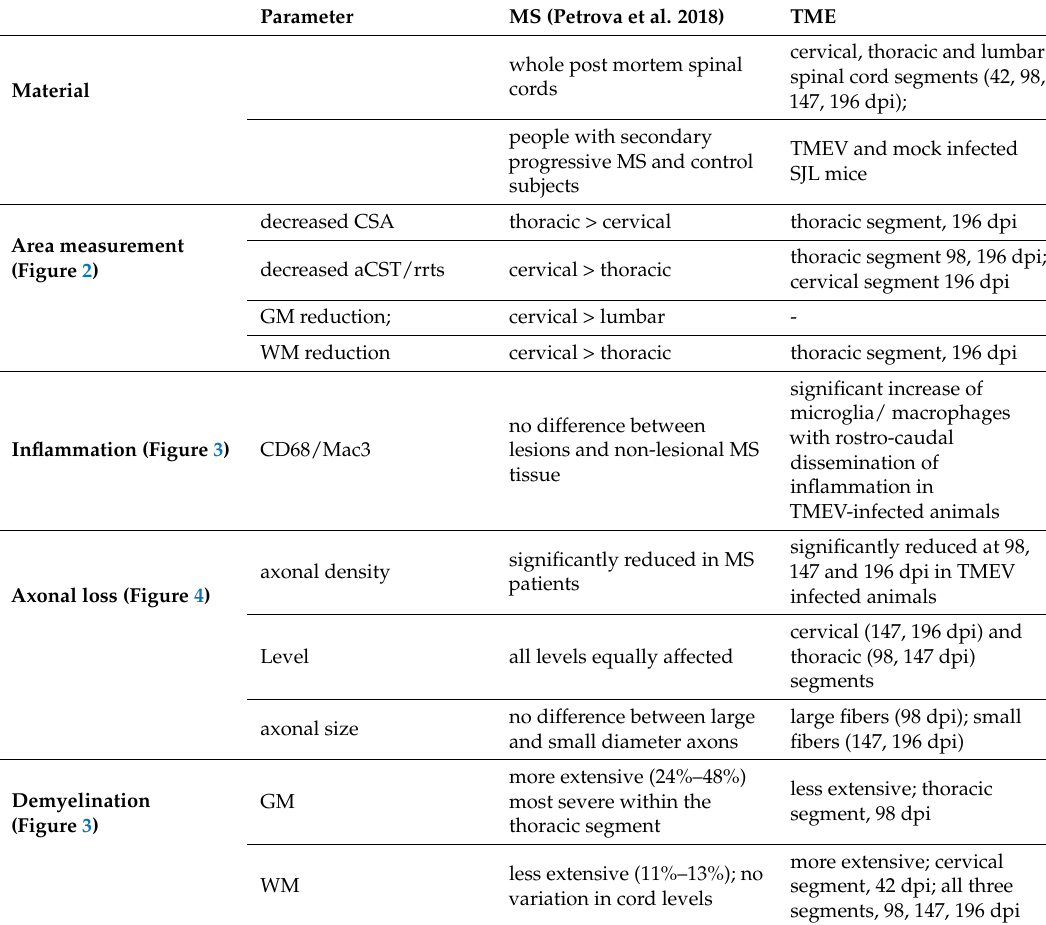
Table 1. Direct comparison between Theiler’s murine encephalomyelitis virus induced